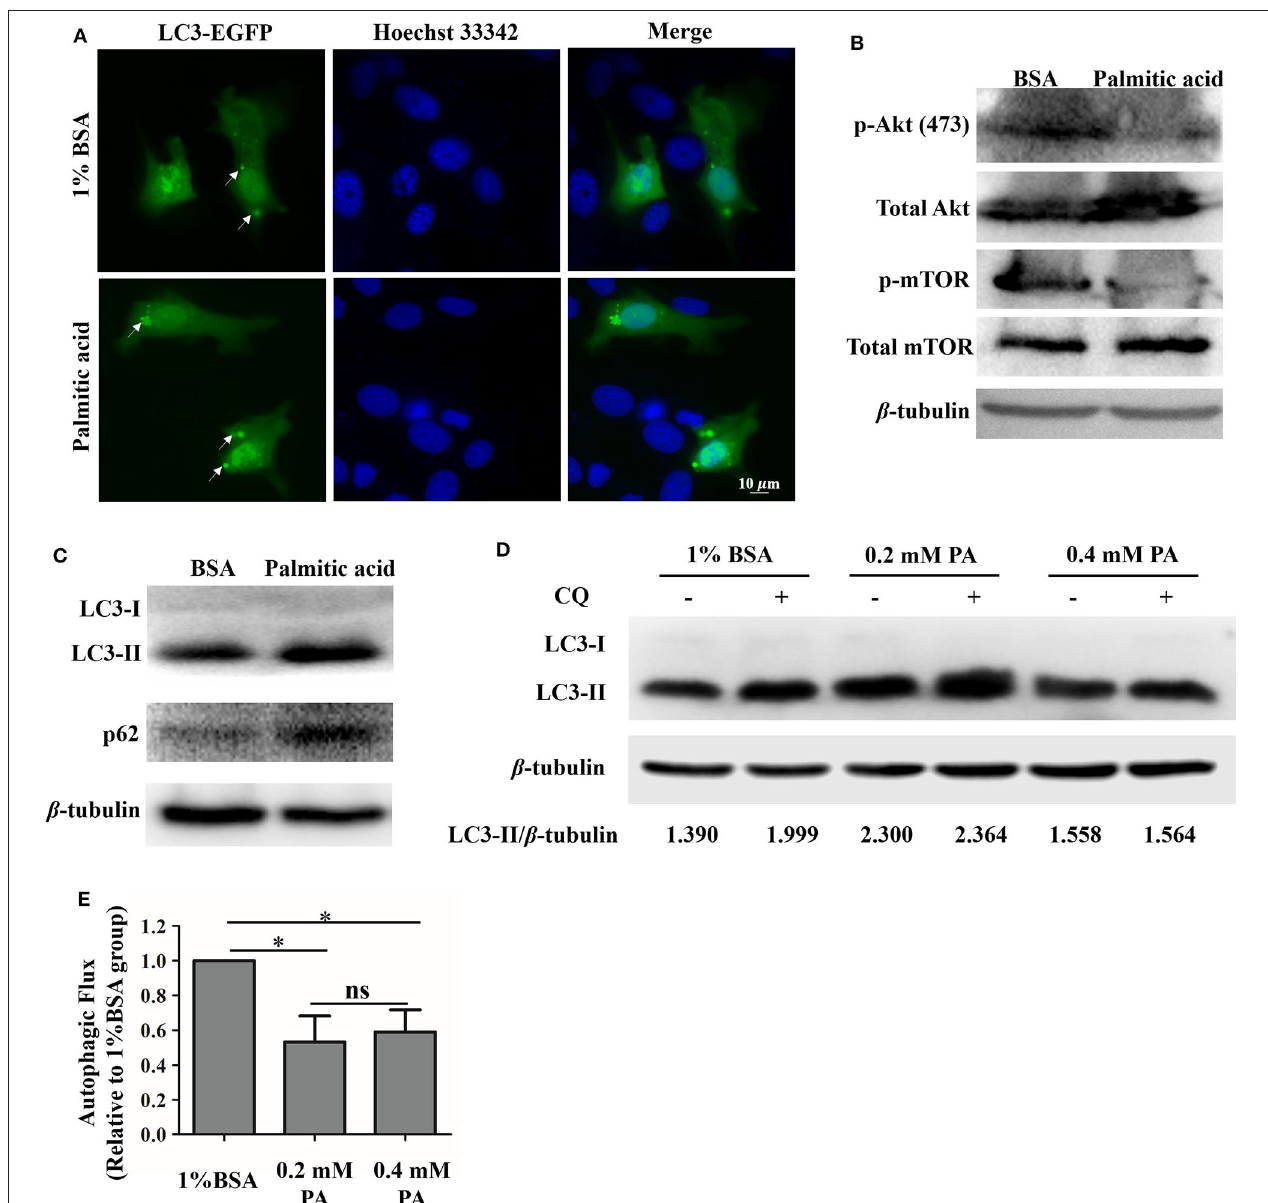
FIGURE 5 | Palmitic acid impacted autophagic flux in GS cells. (A) Accumulation of GFP-LC3 (green) were observed after palmitic acid treatment. GS cells were transfected with C1-EGFP-LC3 plasmid, then incubated with or without 0.4mM palmitic acid. Cells were fixed with 4% polyformaldehyde and staining with Hoechst33342. Fluorescence was observed under the fluorescence microscope (Zeiss). (B) Representative image of phospho-Akt (Ser473) [p-Akt (ser473)], and phospho-mTOR (p-mTOR) detection was performed to verify Akt and mTOR inhibition by 1% BSA or palmitic acid (0.4mM) treatment. β -tubulin was used as the internal control. (C) The expression levels of LC3, and p62 in cell lysates were evaluated after the incubation of 1% BSA or palmitic acid (0.4mM) for 24h. Western blot assay was carried out, and β -tubulin was used as the internal control. (D) GS cells were incubated with 1% BSA, 0.2mM palmitic acid, or 0.4mM palmitic acid for 24h, and CQ was added for the last 4h treatment. Western blot assay was carried out to detect the LC3-II and β -tubulin levels in cell lysate. Band intensity was calculated using Image J software, and the LC3-II protein level was presented by the ratio of LC3-II/ β -tubulin. (E) Autophagic flux was measured. Briefly, after measuring the LC3-II protein level (LC3-II/ β -tubulin) in each group, the histogram was made referring to the ratio of LC3-II level in cells treated with CQ to that of untreated cells. Setting the ratio in 1% BSA treated group as 1-fold. The data are represented as mean ± SD, and the statistical significances were determined with Student’s t -test, n = 3. The significance level was defined as * p <